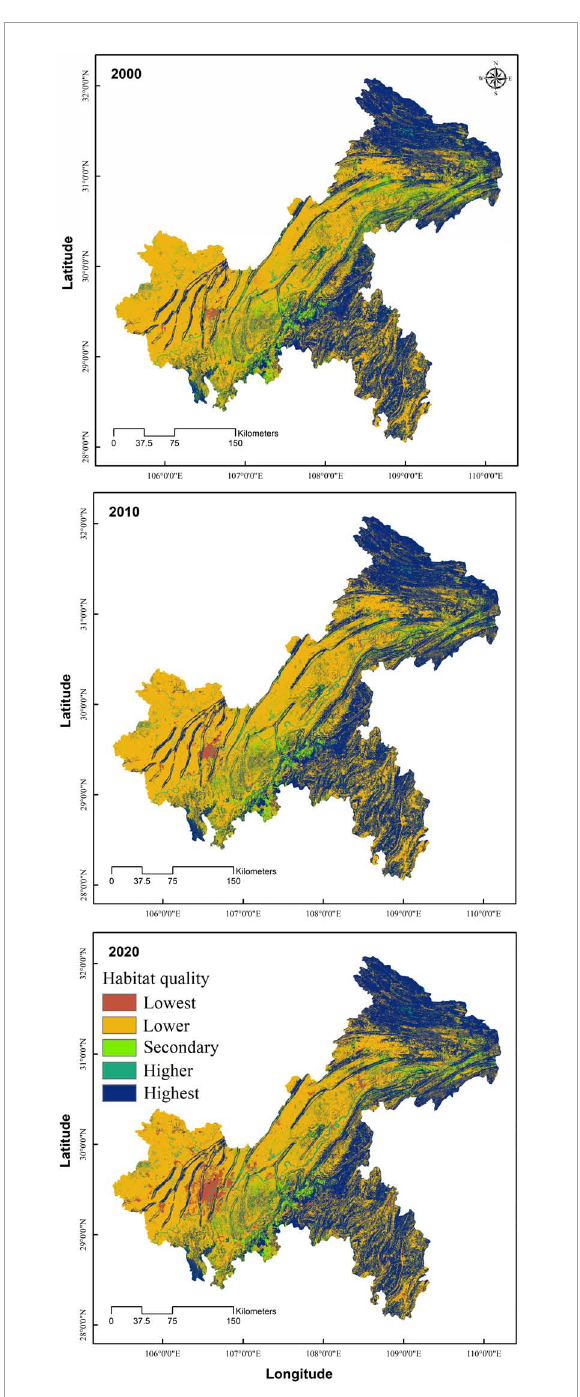
FIGURE3 Spatial distribution of habitat quality of Chongqing Municipality in 2000, 2010, and 2020.